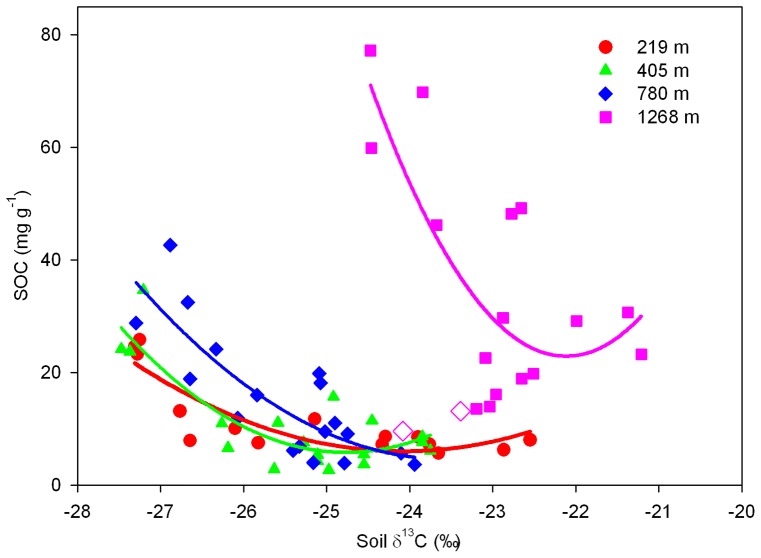
Relationships between SOC concentration (mg g−1) and soil δ13C by soil depth for four altitudes in the Lushan Mountain.The fitted models are: y = 870.58+71.82x +1.49x
2, r
2 = 0.76, and p = 0.0002, for the 219 m site; y = 1881.58+149.87x +3.03x
2, r
2 = 0.72, and p<0.0001, for the 405 m site; y = 1250.35+105.77x +2.25x
2, r
2 = 0.68, and p = 0.0002, for the 780 m site; and y = 4265.44+383.58x +8.67x
2, r
2 = 0.57, and p = 0.0041, for the 1268 m site.